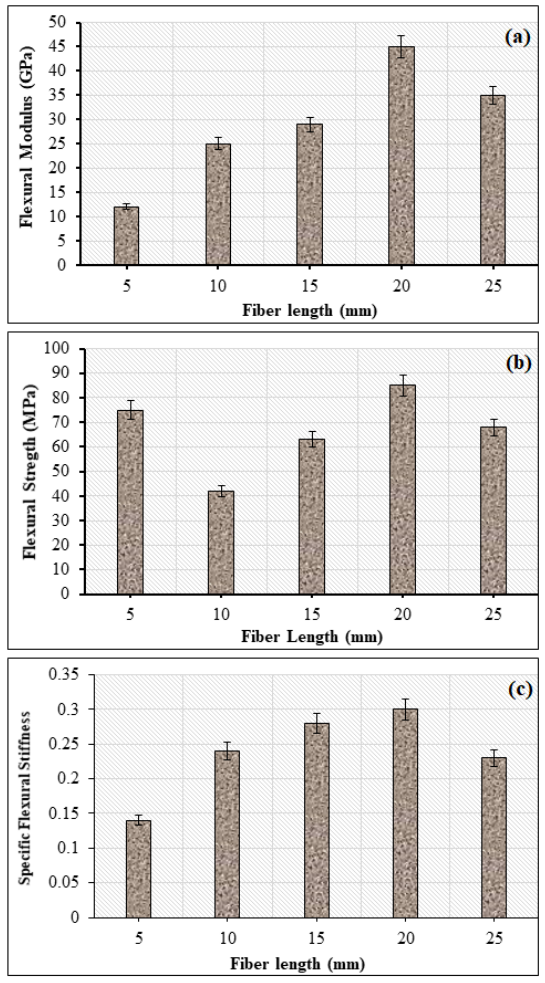
Figure 8. Flexural tests results for ( a ) flexural modulus vs. fiber length, ( b ) flexural strength vs. fiber length, ( c ) specific flexural stiffness vs. fiber length.